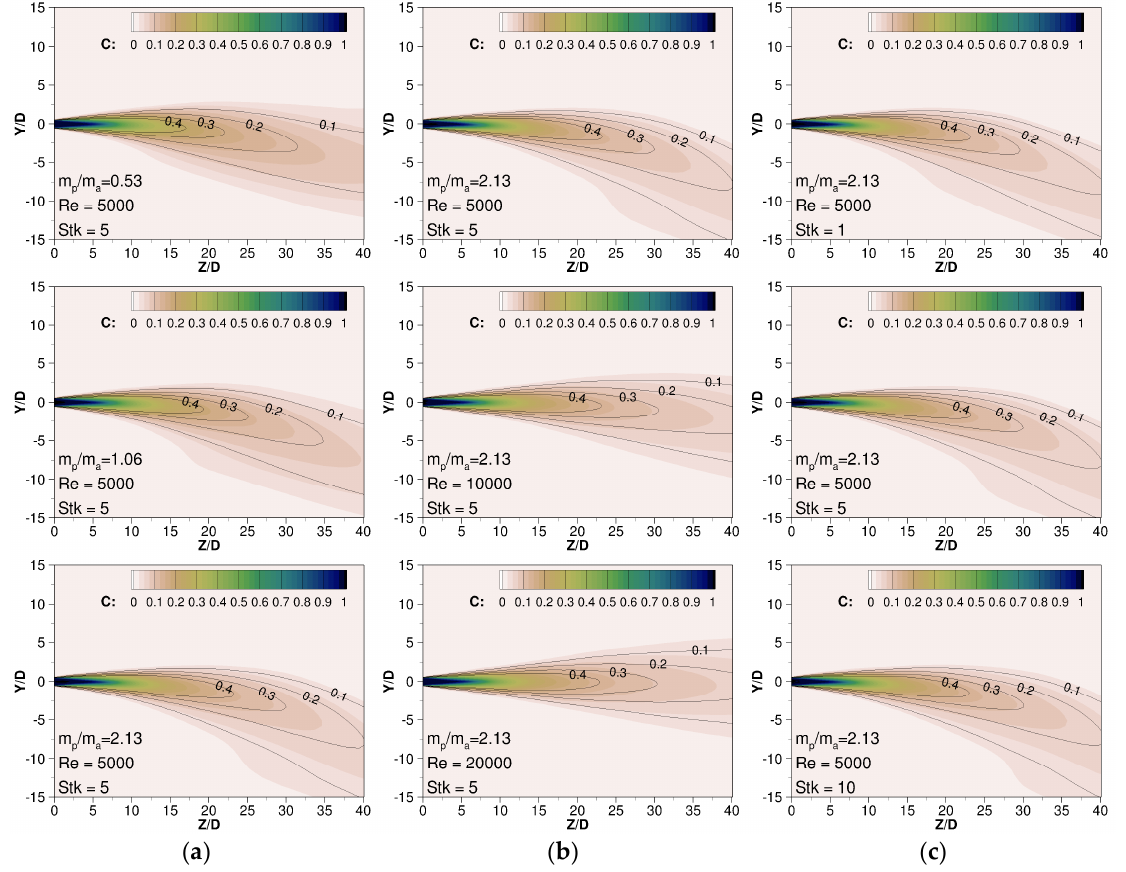
Figure 3. The contours of jet tracer scalar: ( a ) The left side is for different mass loading ratios at Re = 5000, Stk = 5. ( b ) The middle one is for different Reynolds numbers at m_p⁄m_a = 2.13, Stk = 5. ( c ) The right side is for different Stokes number at m p⁄m_a = 2.13, Re = 5000. The lines represent the velocity contour.